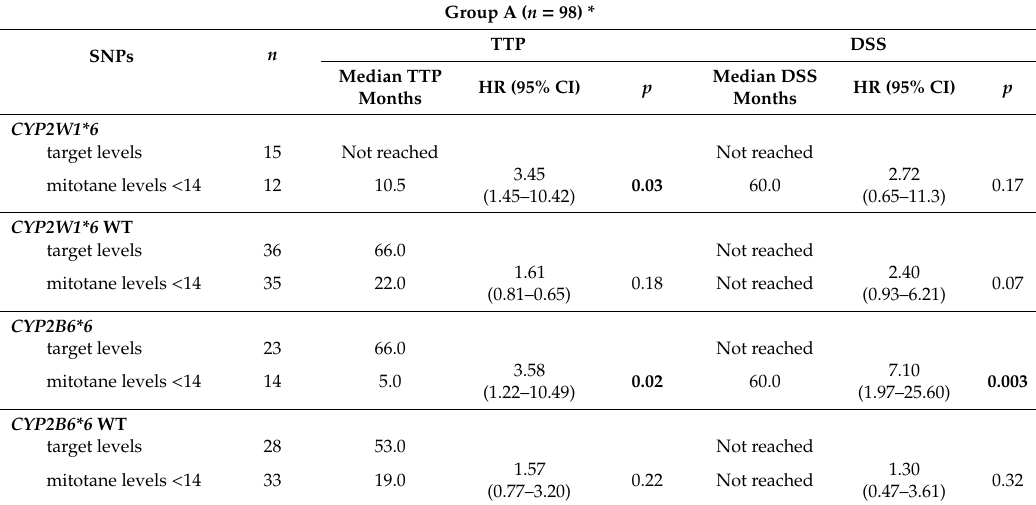
Table 3. Time to progression and disease-specific survival for patients with CYP2W1*6 or CYP2B6*6 correlating with the achievement of the mitotane target levels in group A.